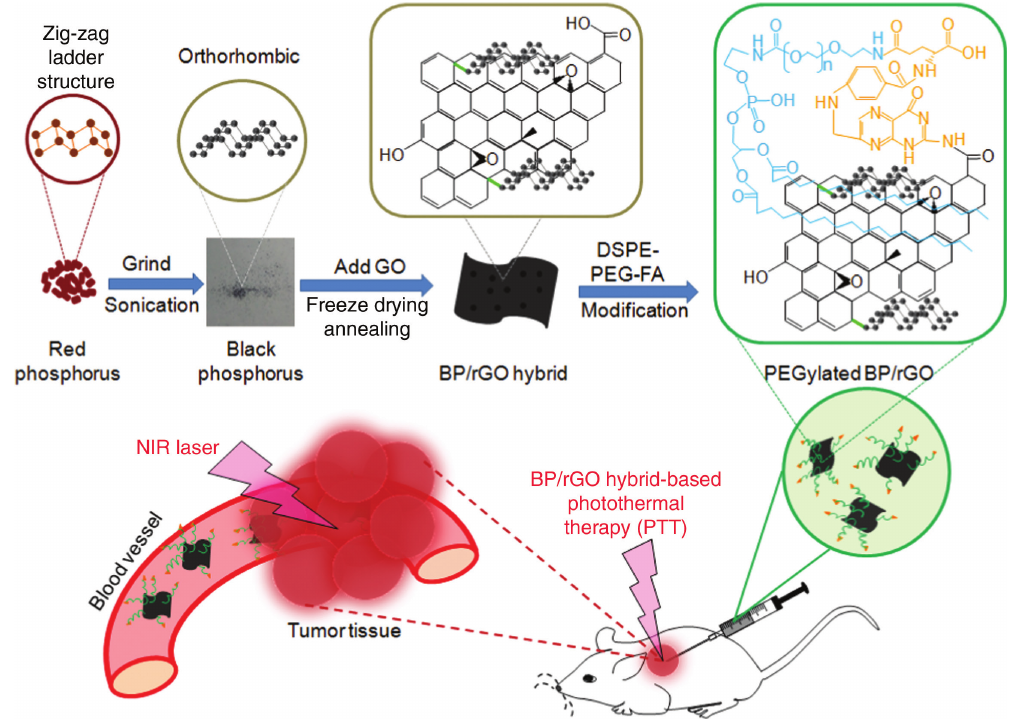
Figure 1: Schematic diagram of synthesis of PEGylated BP/rGO via sonochemical approach and developed as BP/rGO-based photothermal therapy agent for cancer